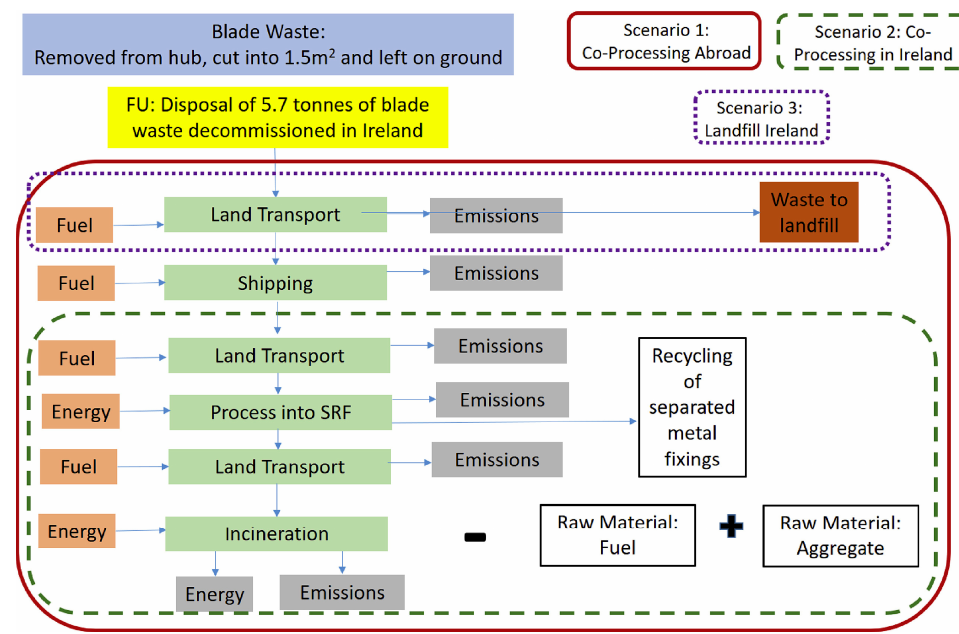
Figure 23. Wind turbine blades life cycle assessment boundary conditions [209].